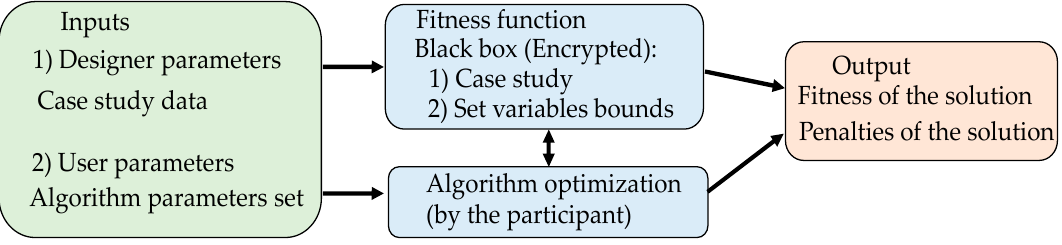
Figure 2. Structure of fitness function (modified from [5]).